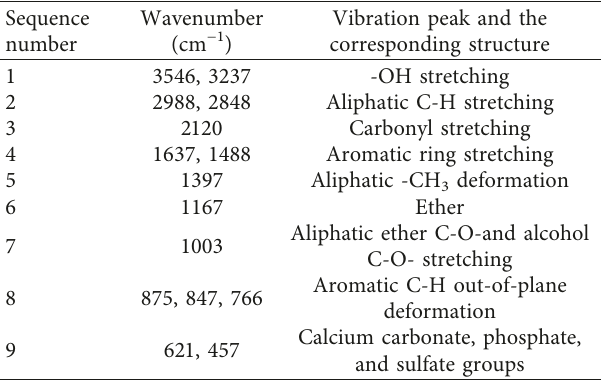
Figure 9: The FT-IR spectra of oil shale dust before and after an explosion. Table 2: Chemical structure in oil